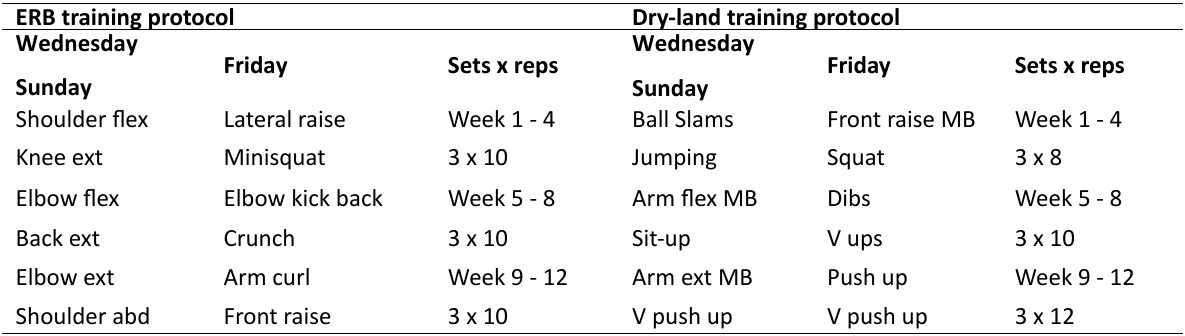
Table 1. The training programs, according to the groups.